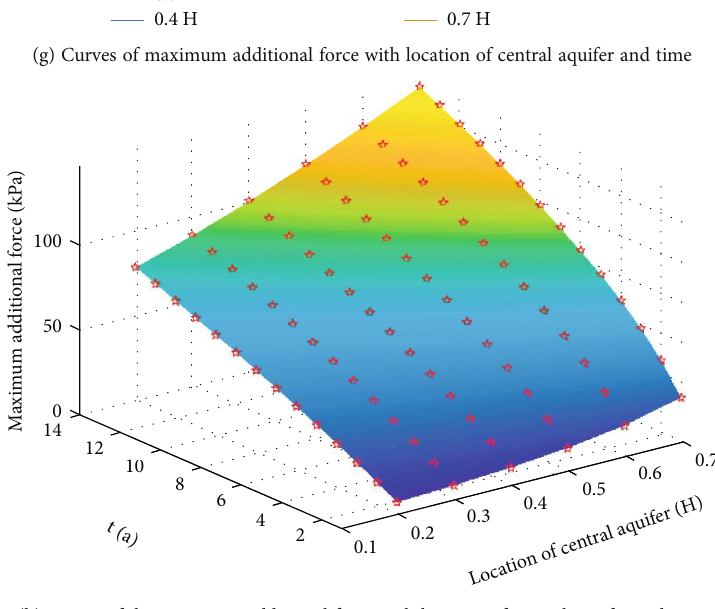
Figure 15: Relationship between the additional force and location of central